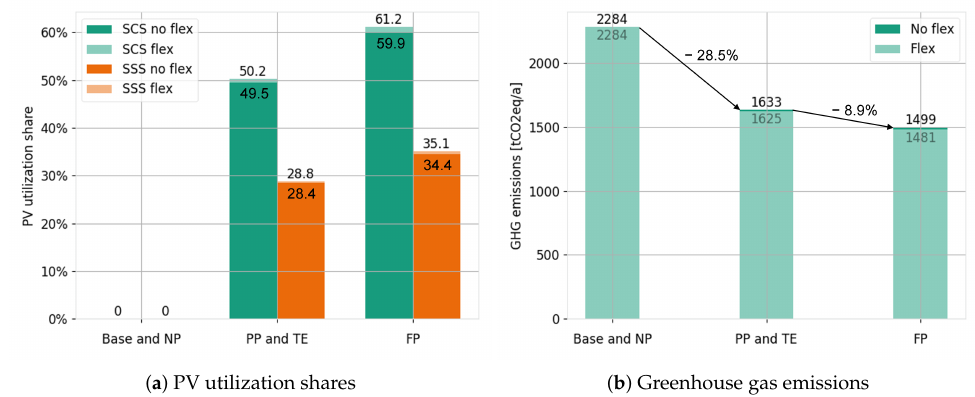
Figure 5. Impact of prosumership on PV Self-Consumption Share (SCS), Self-Sufficiency Share (SSS) (left) and greenhouse gas emissions (right). Some use cases have the same results and have been grouped together. The Base and No Prosumership (NP) are one group, and the Partial Prosumer- ship (PP) and Tenant Electricity (TE) forms another group. Lighter hues represent the application of